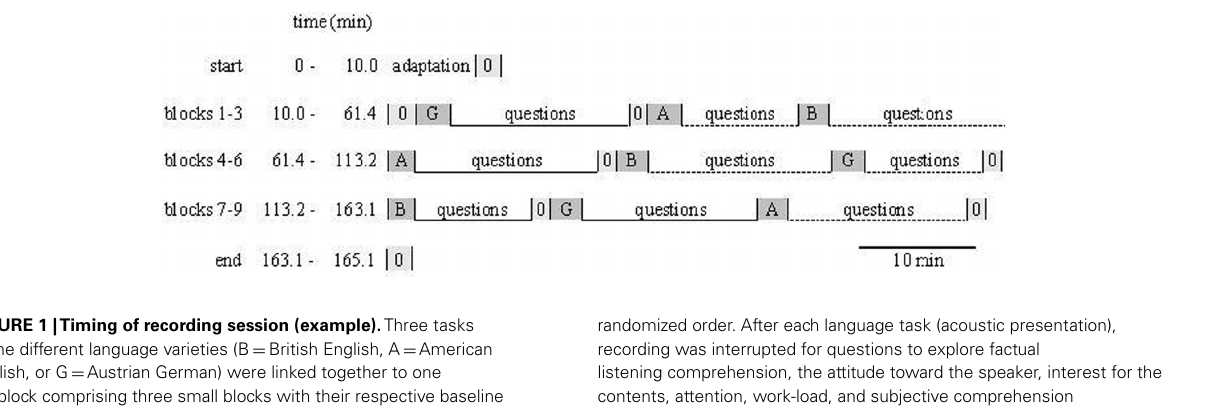
FIGURE 1 |Timing of recording session (example). Three tasks of the different language varieties (B = British English, A = American English, or G = Austrian German) were linked together to one big block comprising three small blocks with their respective baseline conditions, and the three big blocks (1–3, 4–6, 7–9) were presented in